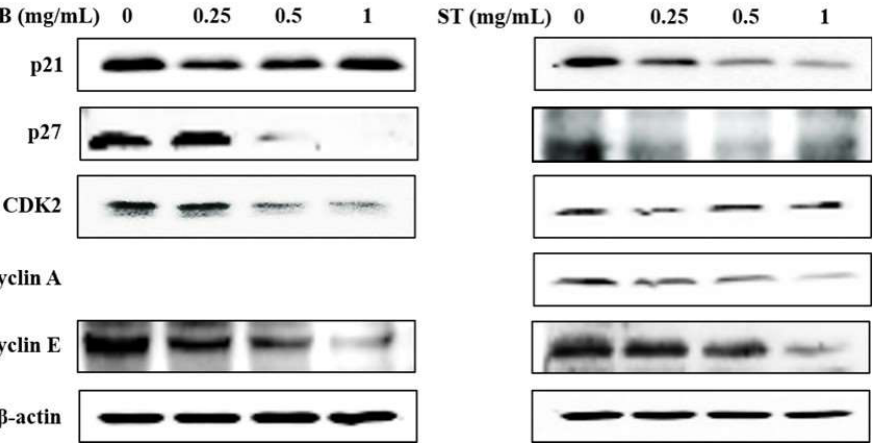
Figure 4. Effect of SB and ST on apoptosis-related protein levels in HSC-3 cells investigated by Western blot analysis. Cells were treated with 0.25, 0.5 and 1 mg/mL of SB and ST for 72 h. β-actin was used as a loading control. Figures showed the representative blots from one of three experiments that gave similar results.